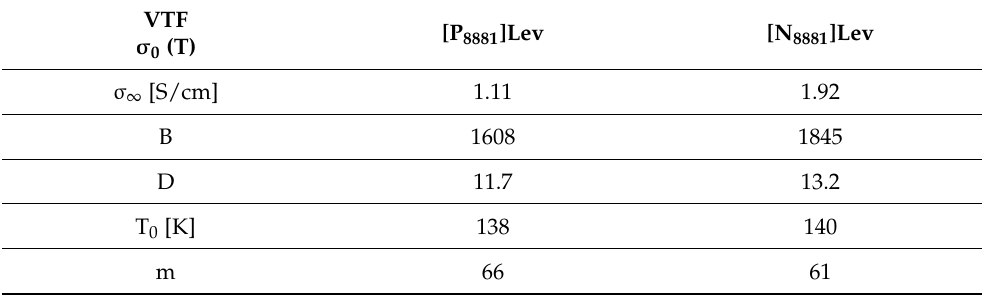
Table 1. VFT parameters obtained from fitting of conductivity for [N 8881 ]Lev and [P 8881